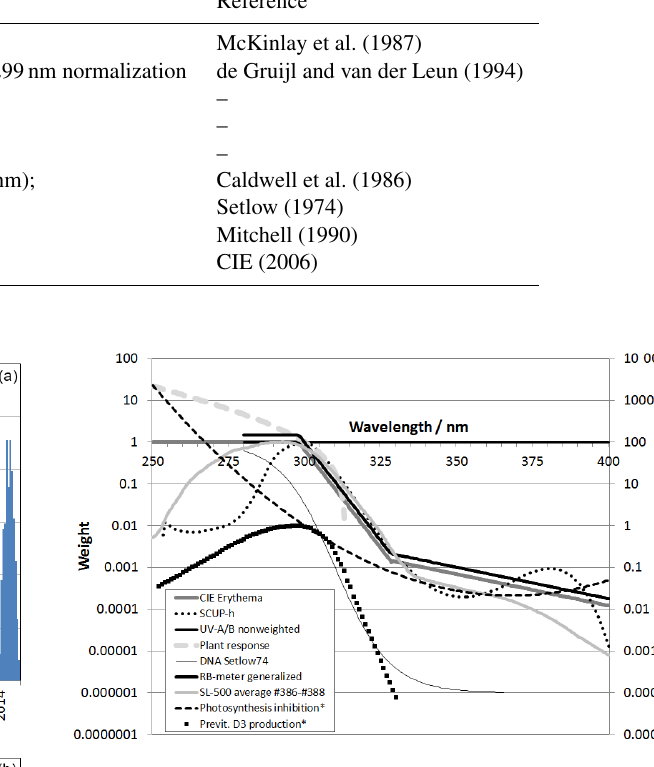
Figure 9. Action spectra used routinely in the processing to derive weighted dose rates from Brewer UV